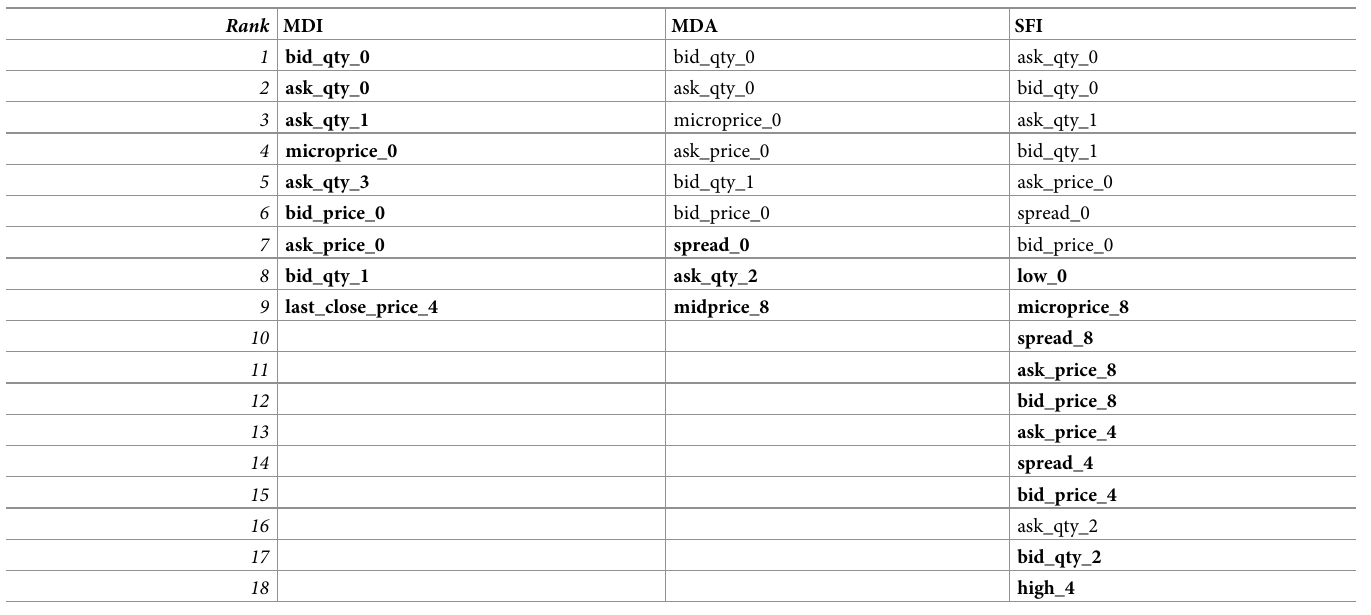
Table 1. Features ordered by importance according to the metrics MDI, MDA and SFI.